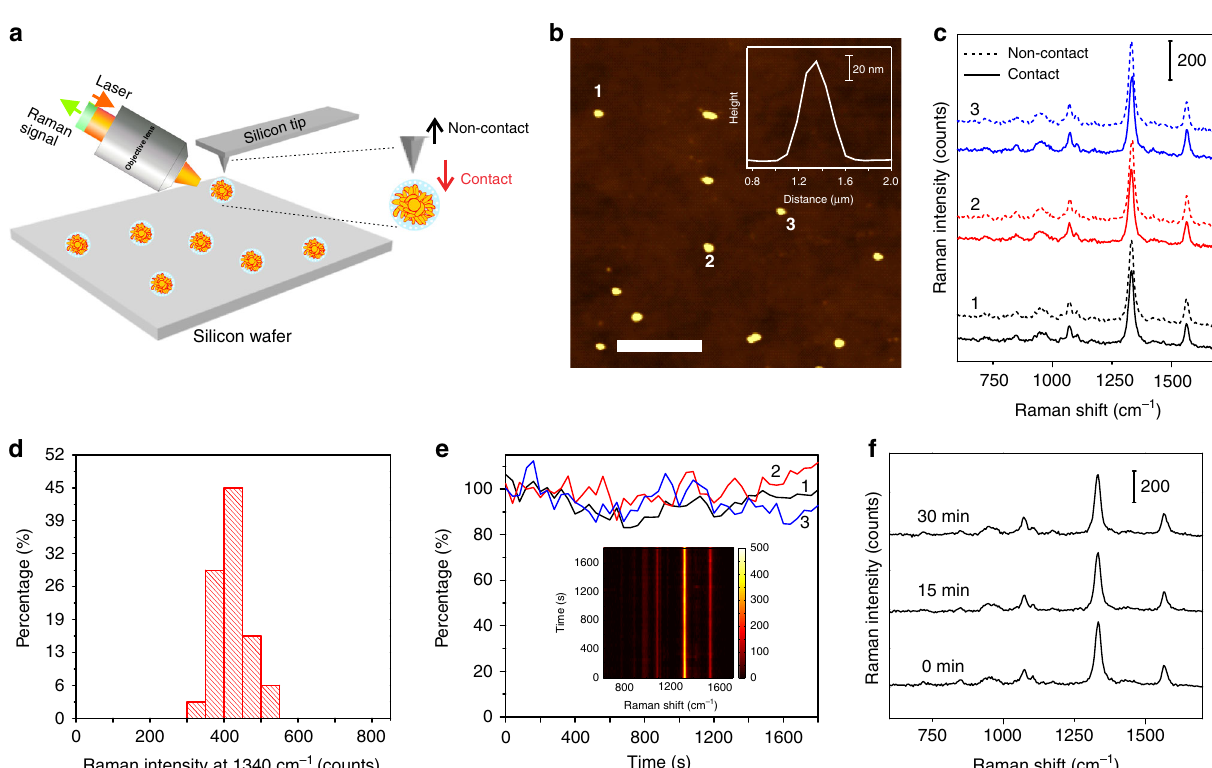
Fig. 4 AFM-correlated single-NP nano-Raman analysis of the P-GERTs. a Schematic illustration of AFM-correlated nano-Raman spectroscopy. b A representative AFM image of MS P-GERTs on silicon wafer. The scale bar is 5 μ m. The inset shows a typical cross-section pro fi le of a single MS P-GERT. c SERS spectra of three single MS GERTs (particle 1, 2, and 3) indicated in panel b measured in contact and non-contact modes. d Distribution diagram of the SERS intensity (1340 cm − 1 ) of thirty-four single MS GERTs from different areas on silicon wafer. e Photostability measurements of three single MS GERTs under continuous laser irradiation for 30 min, monitored by the integrated band area at 1340 cm − 1 . The inset shows a typical time-resolved SERS spectral map of a single GERT during continuous irradiation for 30 min. f Three representative SERS spectra at selected irradiation times under irradiation from the same particle. All measurements were performed with a 633 nm laser, 110 μ W power, 10 s acquisition time, and ×100 objective